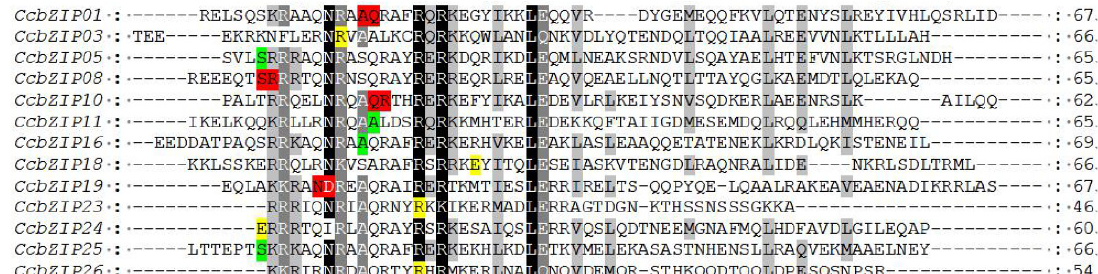
Figure 3. Analysis of splicing phase of intron in the bZIP domains. The yellow letters and the green letters mean splicing sites are located after the first and second nucleotide of a codon, respectively. The red letter means splicing sites are located between two codons. Black, medium gray, and light gray indicate the conserved percent of 100%, >80%, and >60%, respectively.